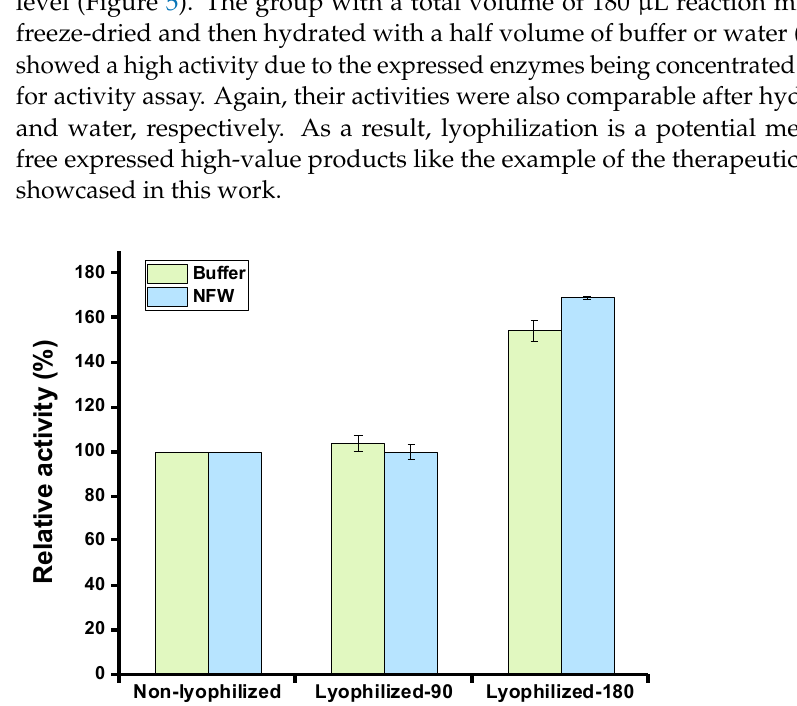
Figure 5. Effects of lyophilization on the serratiopeptidase activity. Lyophilized-90: 90 µ L of cell-free reaction mixture was freeze-dried in one tube; Lyophilized-180: 180 µ L of cell-free reaction mixture was freeze-dried in one tube; Non-lyophilized: cell-free reaction mixture was not freeze-dried; Buffer: acetate buffer (pH 5.0); NFW: nuclease-free water. Values show means with error bars representing standard deviations (s.d.) of at least three independent experiments.